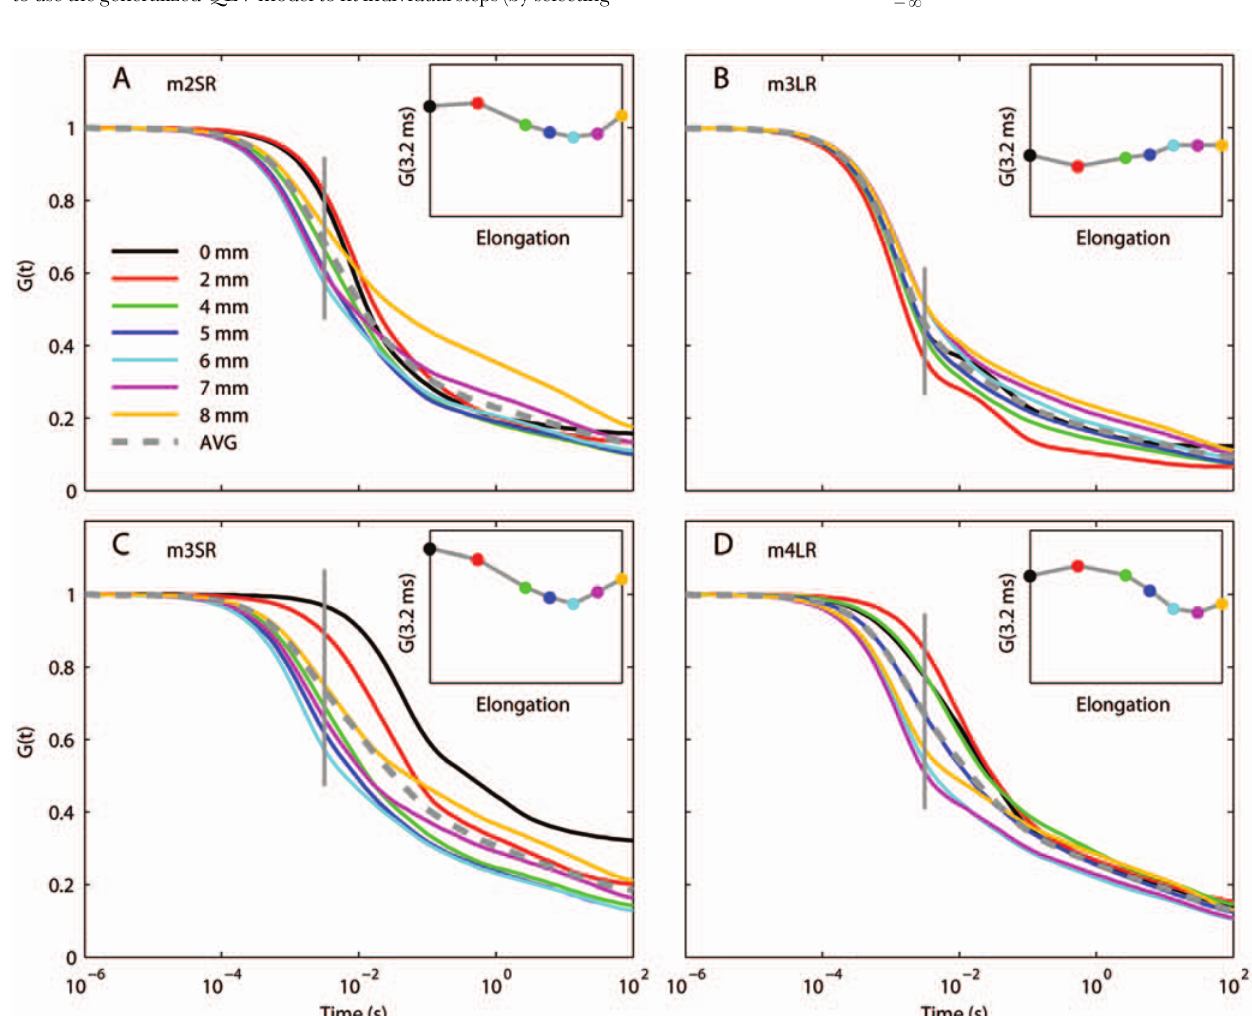
Figure 4. Reduced relaxation function for the generalized QLV model. In each panel we plot, as a function of time, the step response of the linear part of the QLV model (Fig. 1B). Since we used the generalized QLV model there is a curve for each muscle length. If the separability hypothesis held, these curves should all be identical. In the insets we plot the value of the reduced relaxation function at time 3.2 ms (vertical gray line in the main plots) as a function of elongation. Notice how this relationship is in all cases smooth, which would not be expected if the variations were due to random noise or fitting errors. The label in each panel indicates which monkey (m2, m3 or m4) and muscle (LR=lateral rectus, SR=superior rectus) the data are from. AVG: average reduced relaxation function (gray dashed